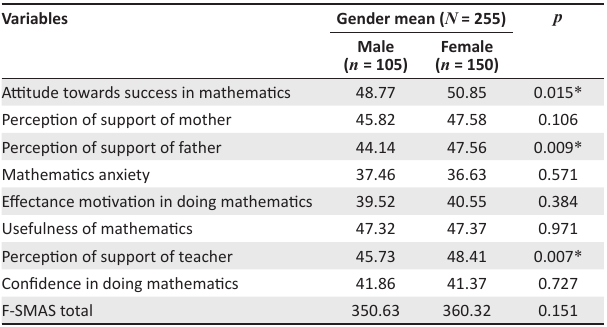
TABLE 1: Male and female differences in pre-service teachers’ attitude towards